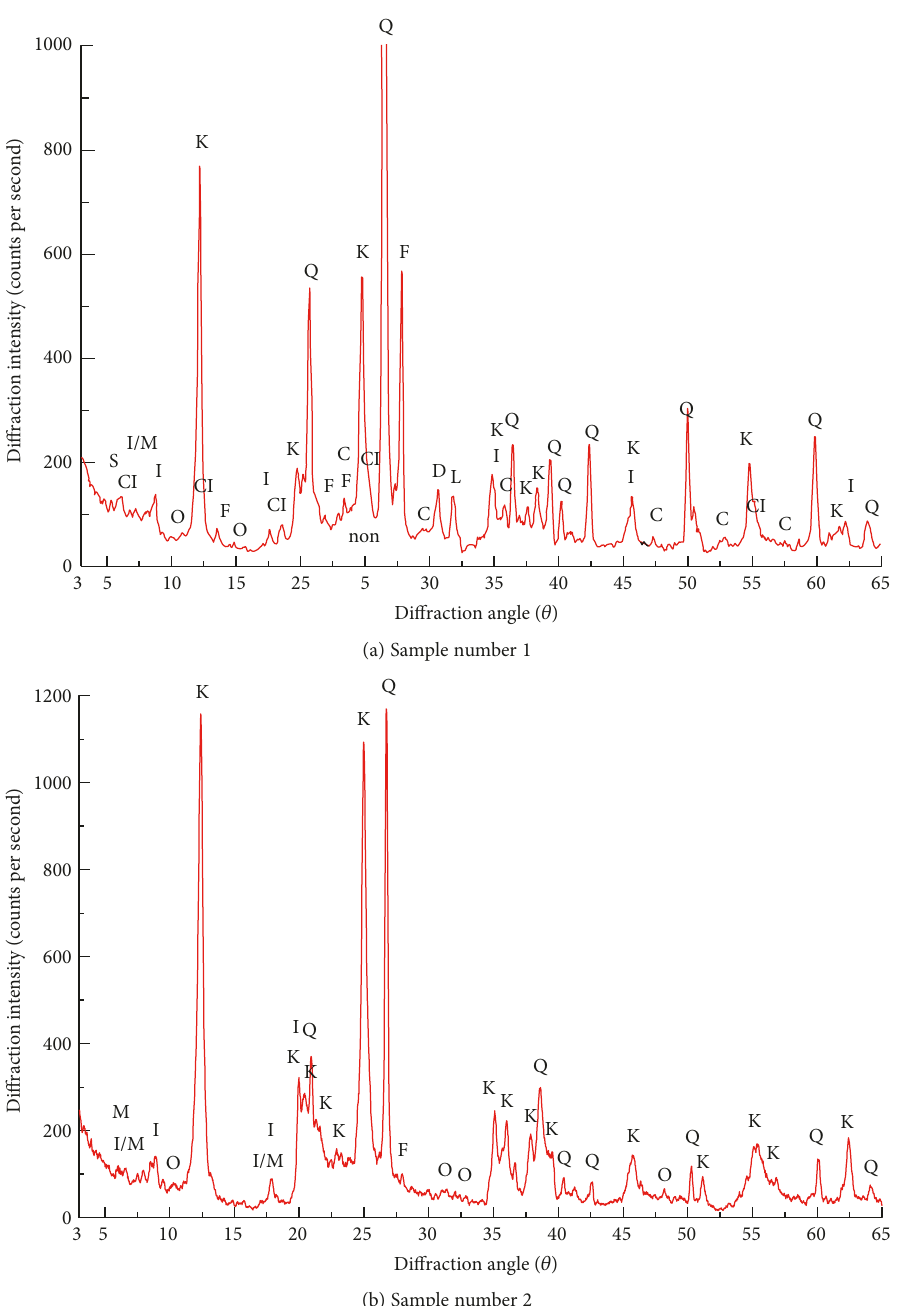
Figure 5: XRD analysis of the weathered coal gangue. (a) Q: quartz (high); K: kaolinite (high); F: feldspar; Cl: Chlorite; I: illite (high); I/M: illite-montmorillonite mixed layer; S: smectite (low); D: dolomite (low); L: siderite (low); C: calcite (low); non: amorphous materials; O: others (low). (b) K: kaolinite (high); Q: quartz (high); I: illite (high); I/M: illite-montmorillonite mixed layer; M: montmorillonite; F: feldspar (low); O: others